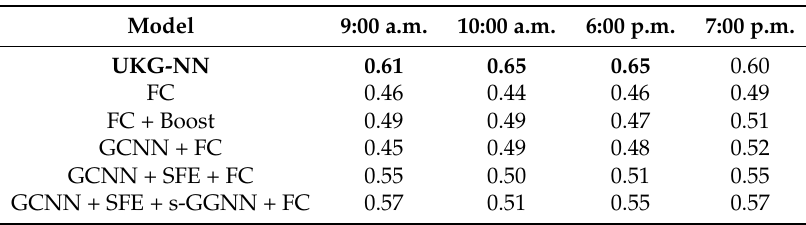
Table 9. Ablation Study for traffic accident